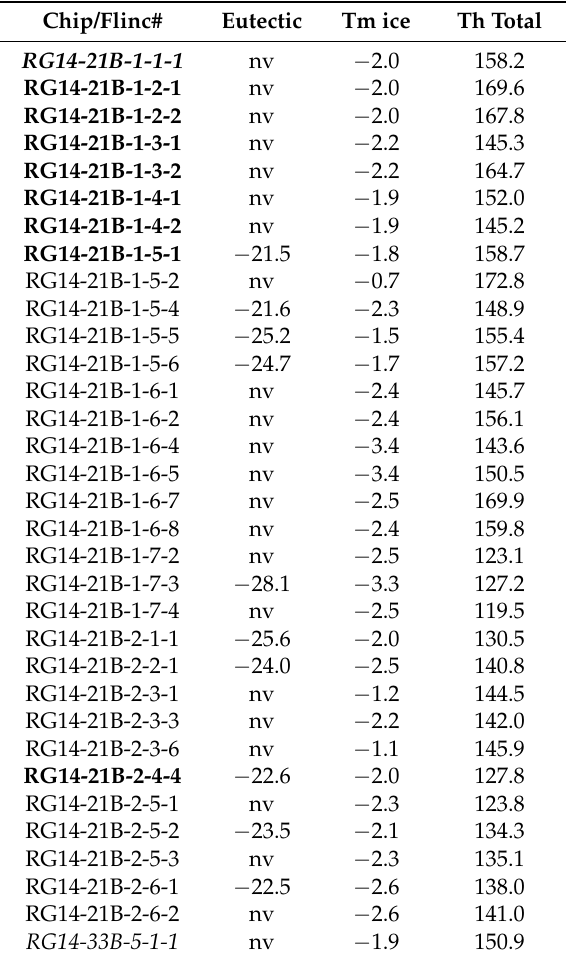
Table 2. Microthermometric measurements on fluid inclusions in quartz and barite.